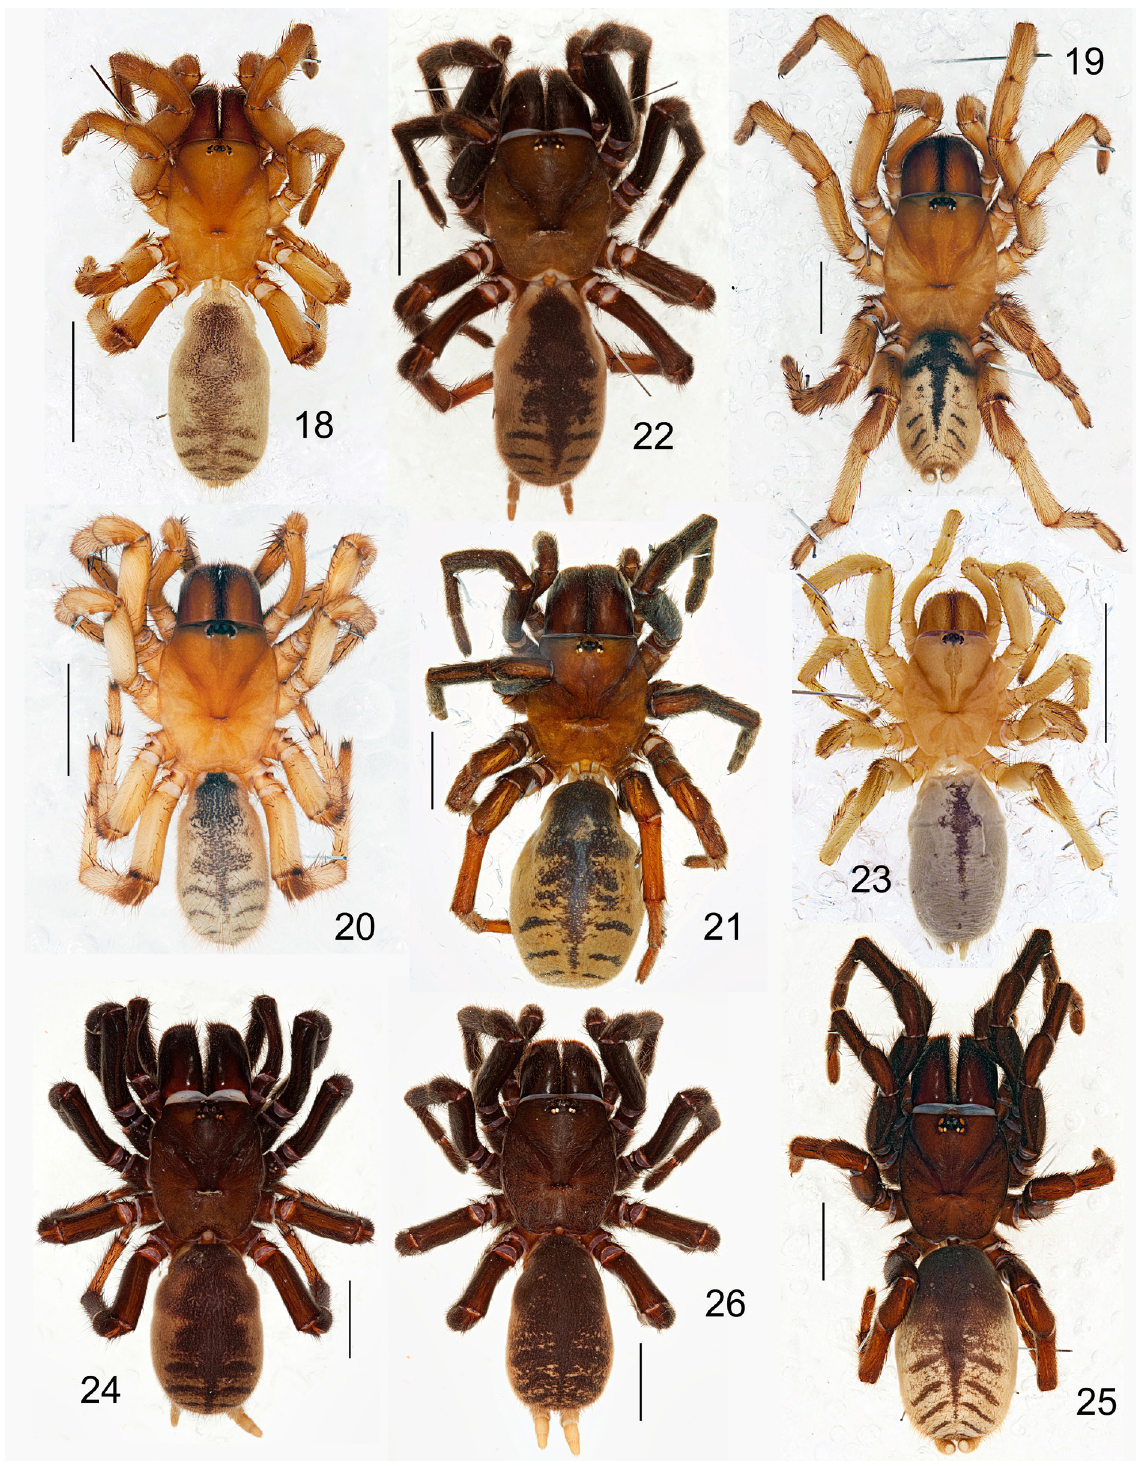
Figs 18–26. Anemesia spp., ♀♀, h abitus, dorsal views. 18 . A. andreevae sp. nov. 19 . A. oxiana sp.